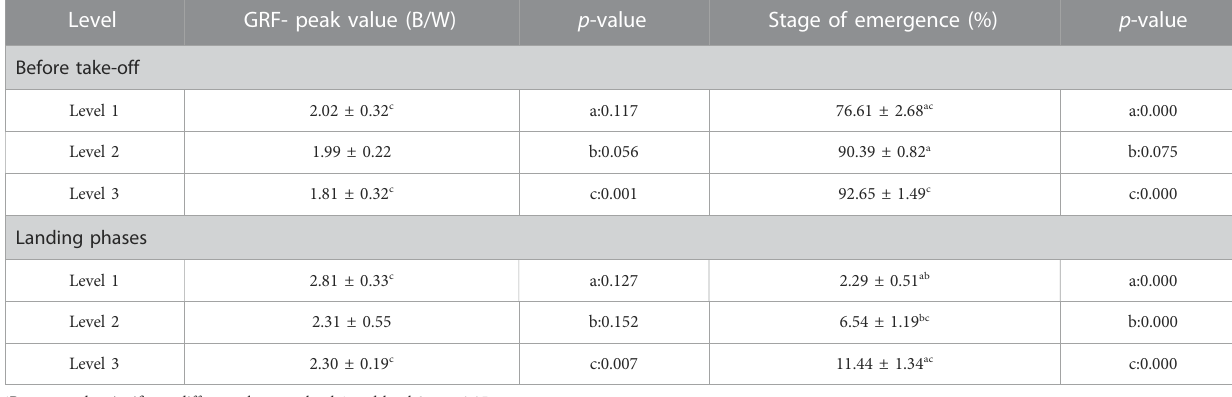
a Represented a signi fi cant difference between level 1 and level 2, p < 0.05. b Represented a signi fi cant difference between level 2 and level 3, p < 0.05. c Represented a signi fi cant difference between level 3 and level 1, p < 0.05.